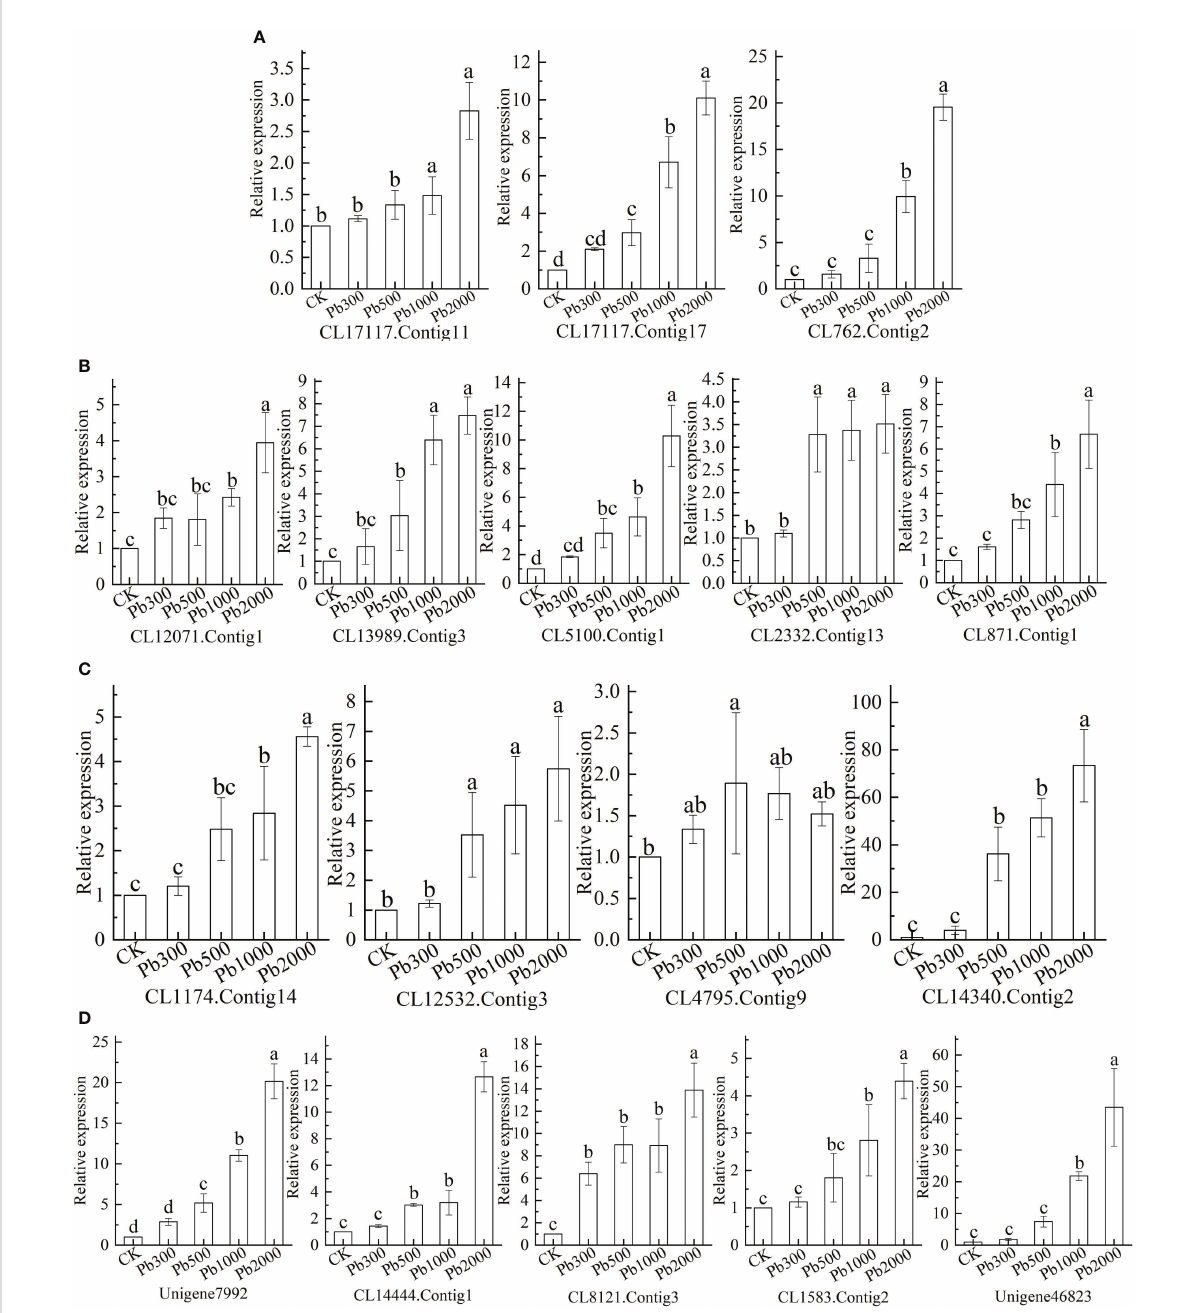
FIGURE 5 The expression of (A) antioxidant-related genes, (B) Ascorbic acid – glutathione (ASA-GSH) cycle-related genes, (C) transporter-related genes, and (D) signal transduction and transcription-related genes in the roots of P. crinitum under different lead stress